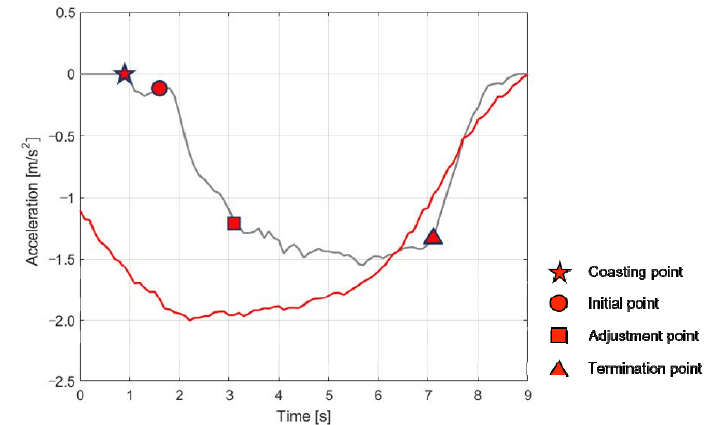
8 of 22 Figure 6. Correlation of initial distance and adjustment distance. In the adjustment section, the driver continuously pushes the brake pedal to keep a safe distance. To simulate the driver’s behavior in the adjustment section, the deceleration model needs the reference value to follow. To find the appropriate equation to be used as reference acceleration, the constant acceleration (CA) model, which is widely used in speed trajectory prediction, was used [17– 21]. The CA model is a parametric equation to calculate the acceleration in order to reach a desirable velocity at a specific location, as shown in Equation (7), where 𝑣 (cid:2870) is the desirable velocity, 𝑣 (cid:2869) is the current vehicle speed, and 𝑑 is the distance to the specific location. 𝑎 (cid:3004)(cid:3002) = (cid:3049) (cid:3118)(cid:3118) (cid:2879)(cid:3049) (cid:3117)(cid:3118) (cid:2870)(cid:3031) .